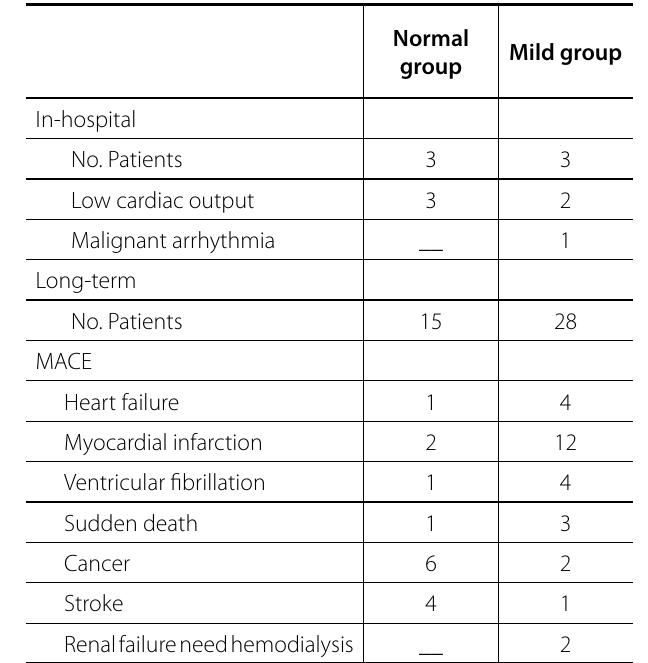
Table 4 . Causes of death.